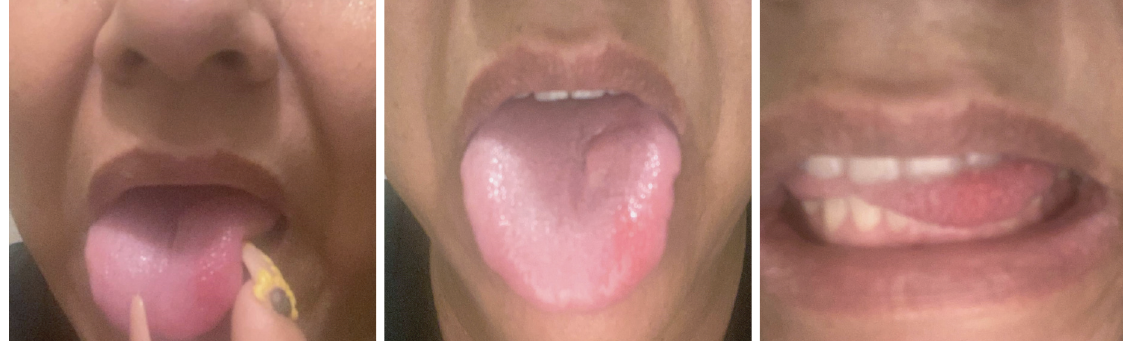
Figure 1: Aphthous stomatitis noted over the left anterolateral tongue (pictures were provided by the